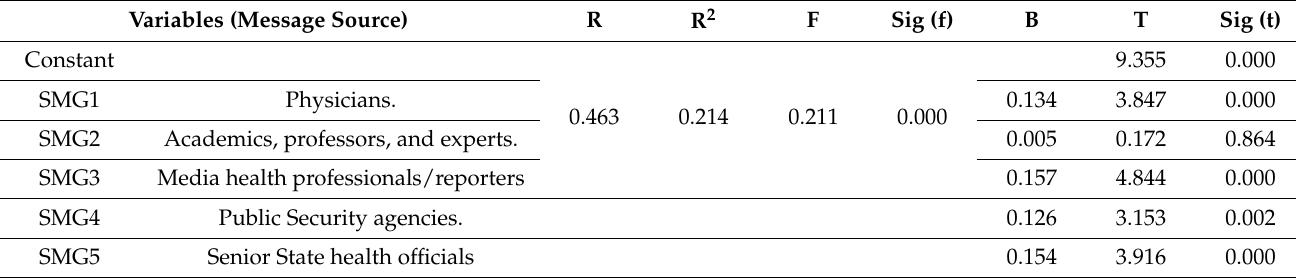
Table 7. Result for (H1c)